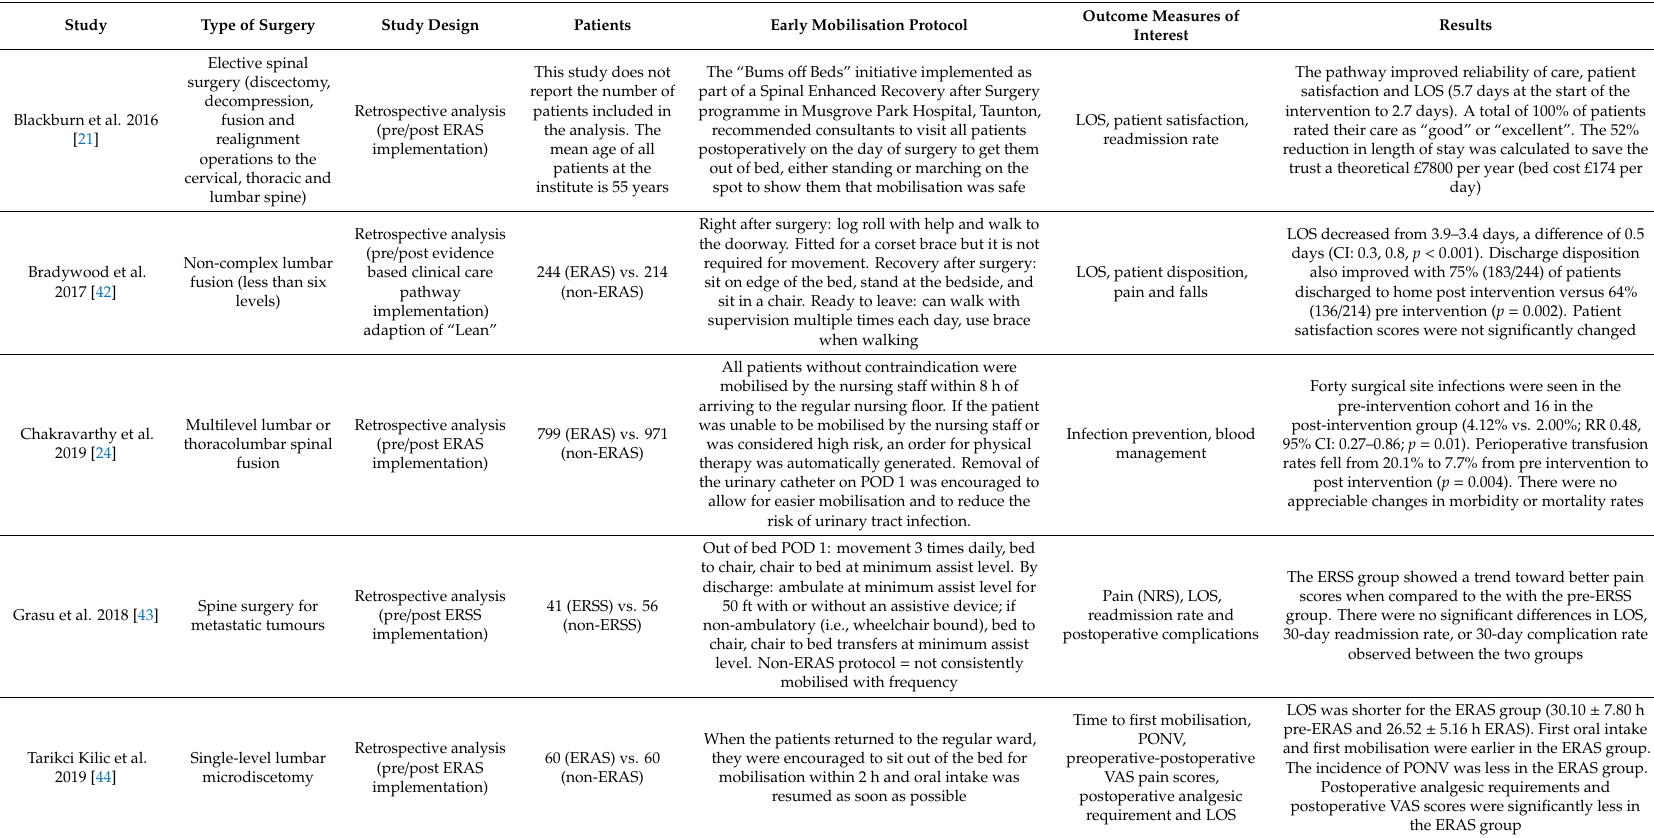
Table 3. Summary of studies (multimodal